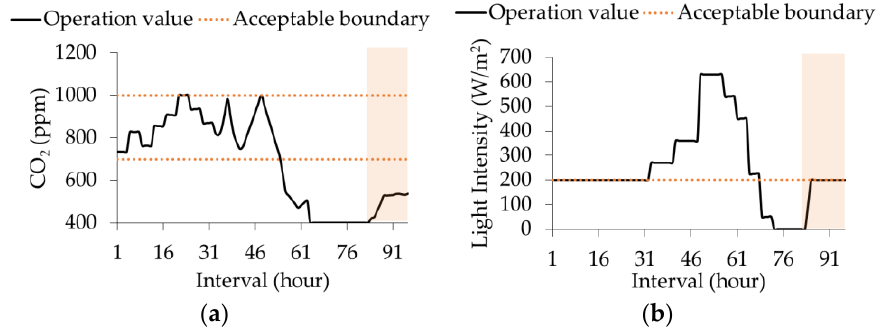
Figure 17. Energy balancing: ( a ) Electrical Energy; ( b ) Heat Energy; ( c ) Cooling Energy.